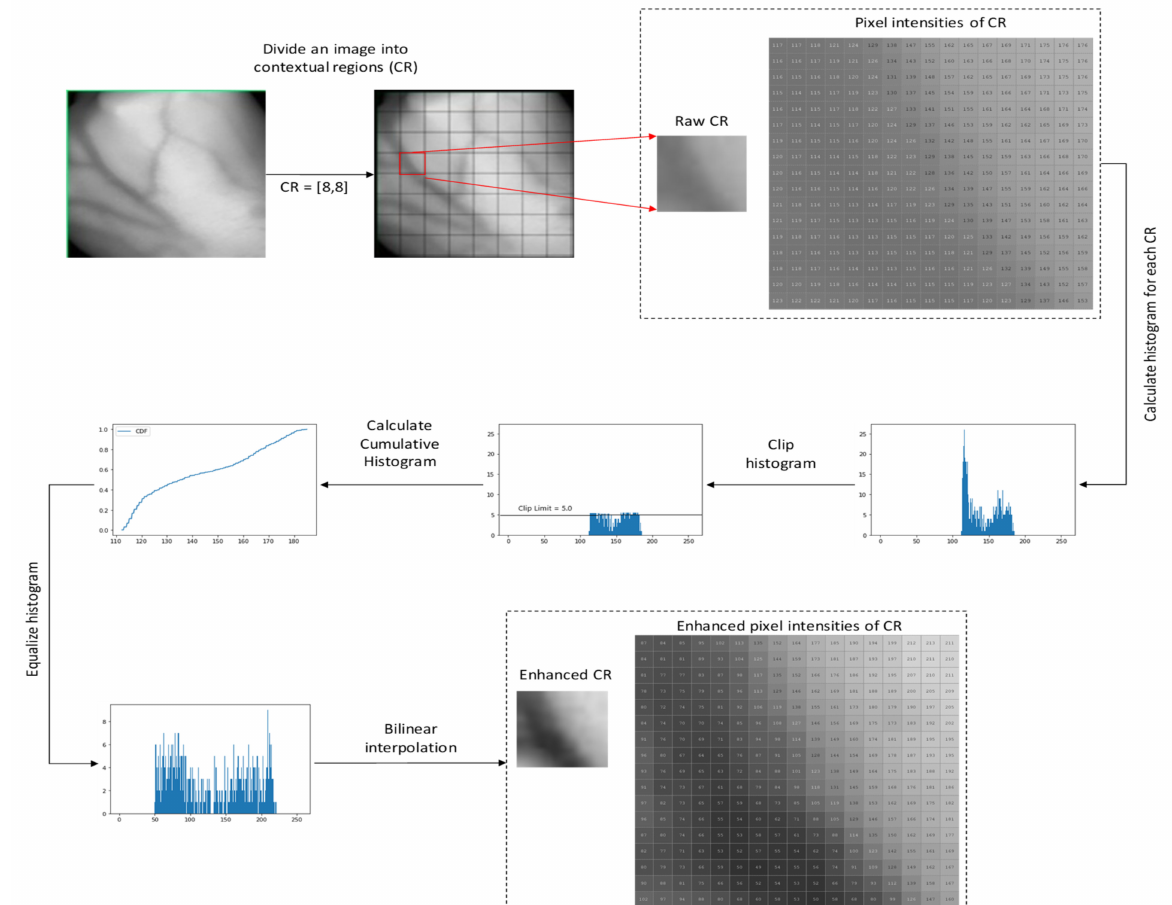
Figure 2. The flow of CLAHE procedures applied on a hand